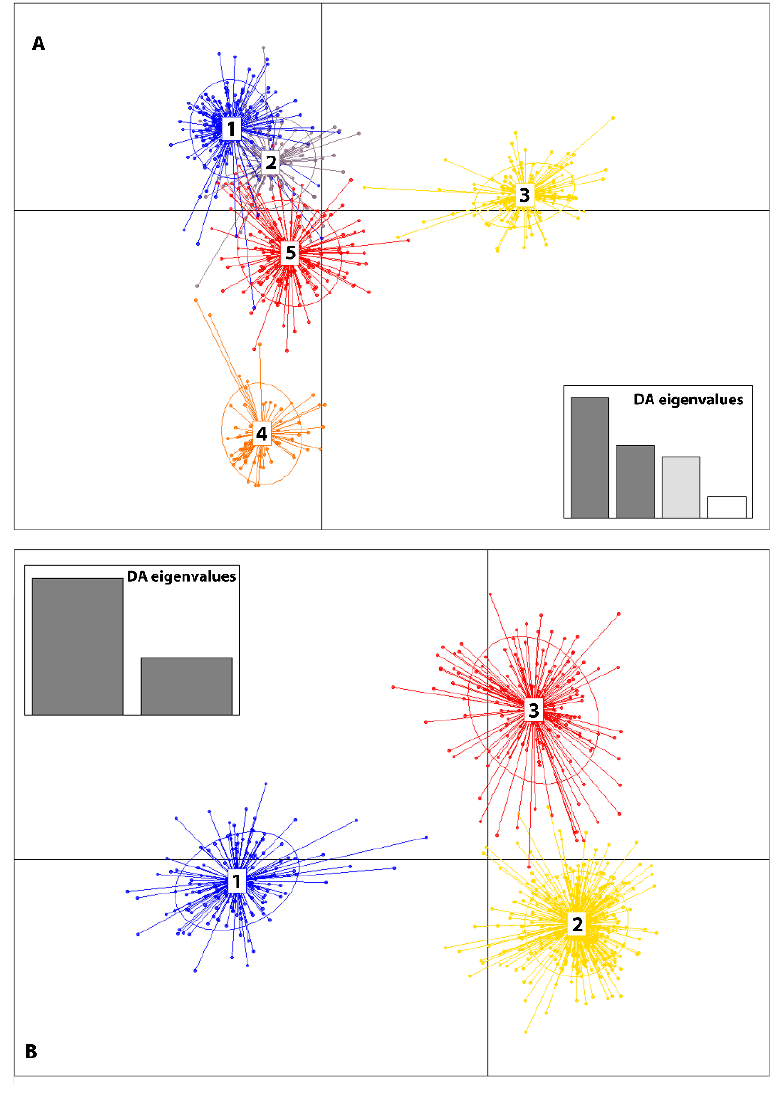
Figure 5. Most parsimonious cluster number estimation using discriminant analysis of principal components (DAPC) iterations from K = 1 to 40 to obtain the successive Bayesian information criterion (BIC) of K = 8 and the putative genetic clusters generated by DAPC using the estimated BIC value of eight ( A ). DAPC results using prior assignment of three putative populations based on STRUCTURE results ( B ). Both plots show the first two axes of the analysis (inset plot). Each color represents a unique population cluster with the corresponding circles showing the prior unique groupings of the 13 putative populations.